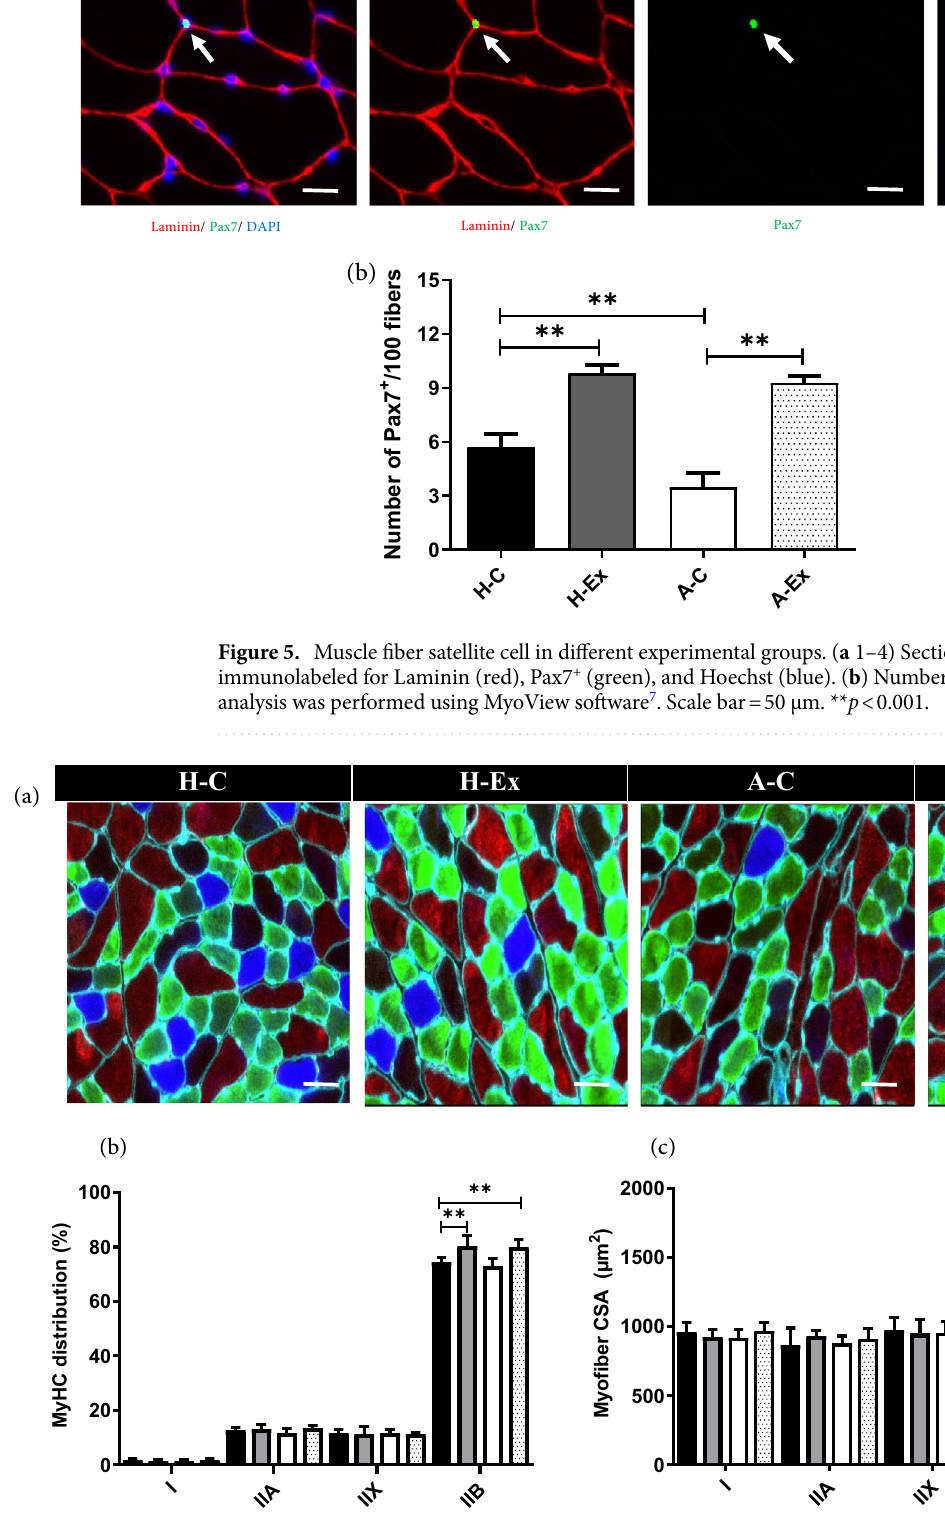
Figure 6. Muscle fiber myosin heavy chains in different experimental groups. ( a ) Sections of gastrocnemius muscle immunolabeled for MyHC I fibers (blue), MyHC IIa (green), MyHC IIx (black), and MyHC IIb (red). ( b ) The effect of resistance training on MyHC distribution (measured with MyoView). ( c ) The effect of resistance training on myofiber CSA in different fiber types (measured with MyoView). Image analysis was performed using MyoView software 7 . Scale bar = 50 µm. ** p <